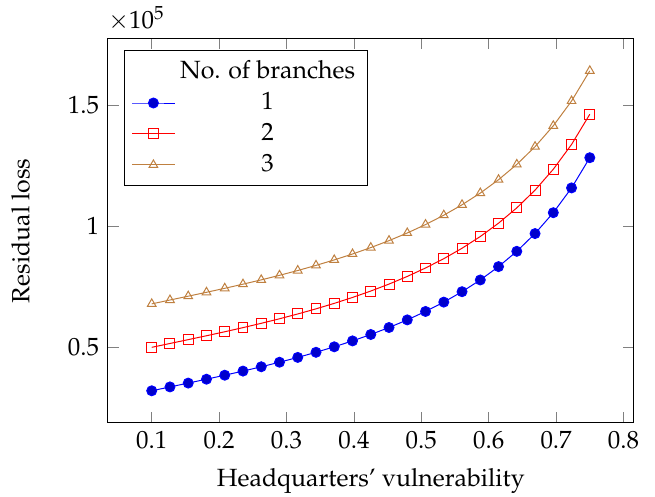
Figure 18. Impact of the intrinsic vulnerability on the residual loss in the limited liability with deductibles